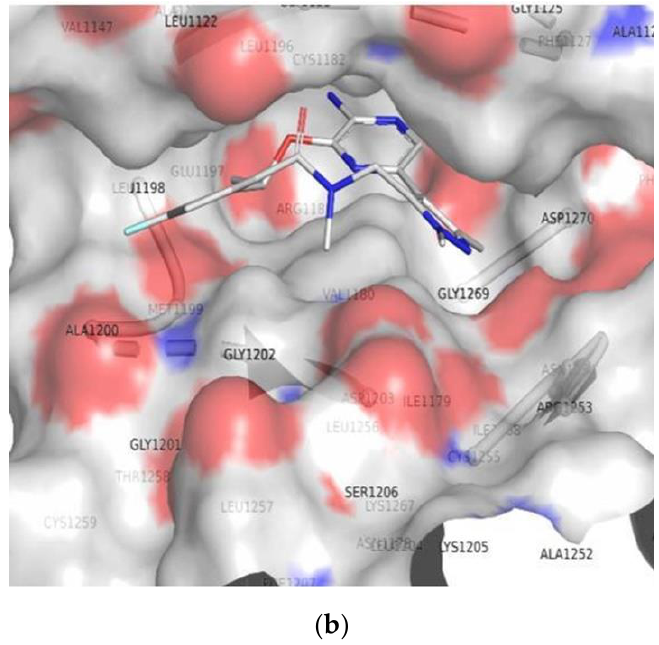
Figure 11. Depiction of the docking pose for the molecule 178 ( a ) and 176 ( b ) within the binding pocket of the ALK tyrosine kinase.